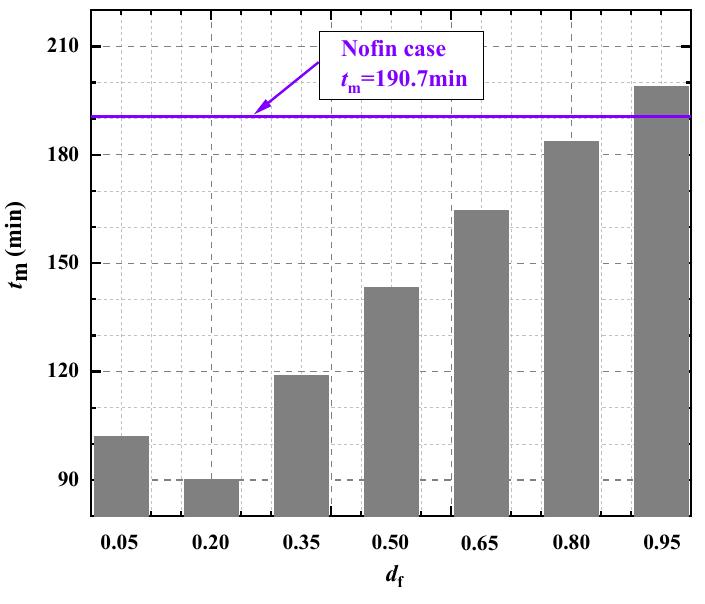
Figure 6. t m , for different d f and no fin case.